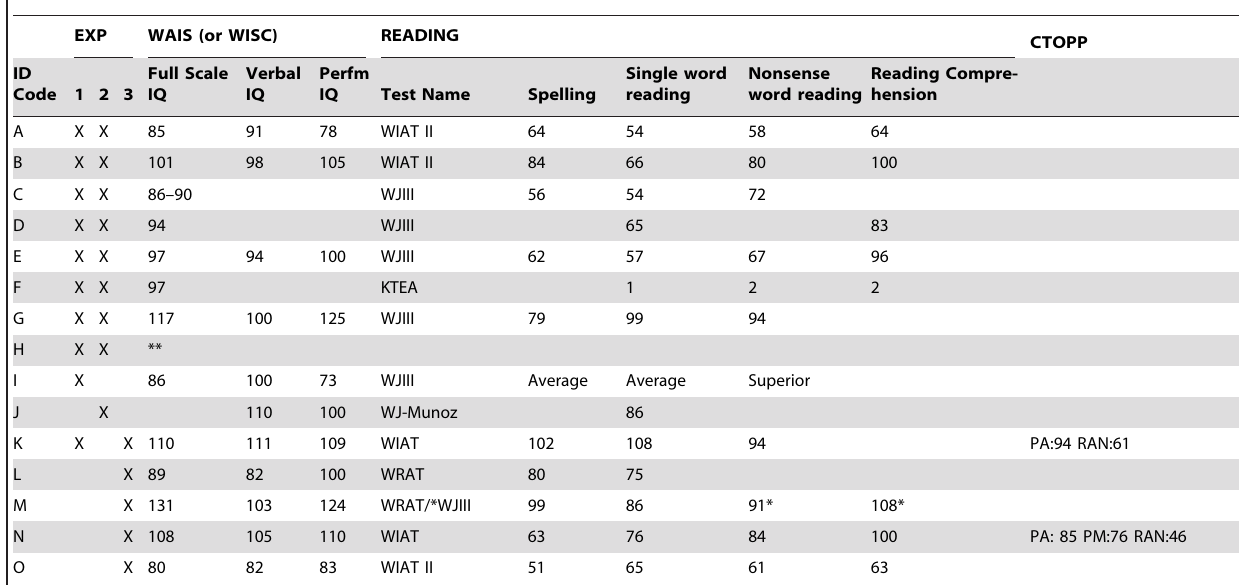
Table 1. Behavioral data for Landmark College participants (SR